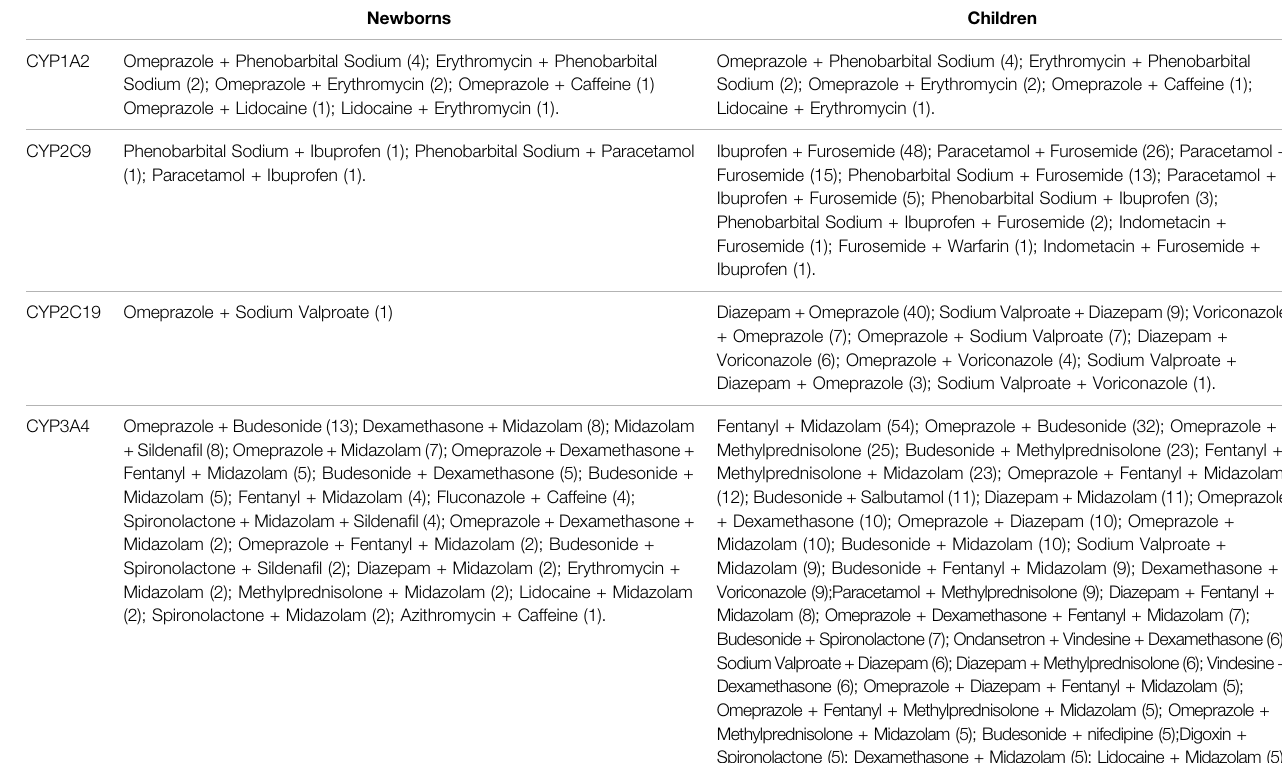
TABLE 3 | Drug combinations related to CYP. Newborns